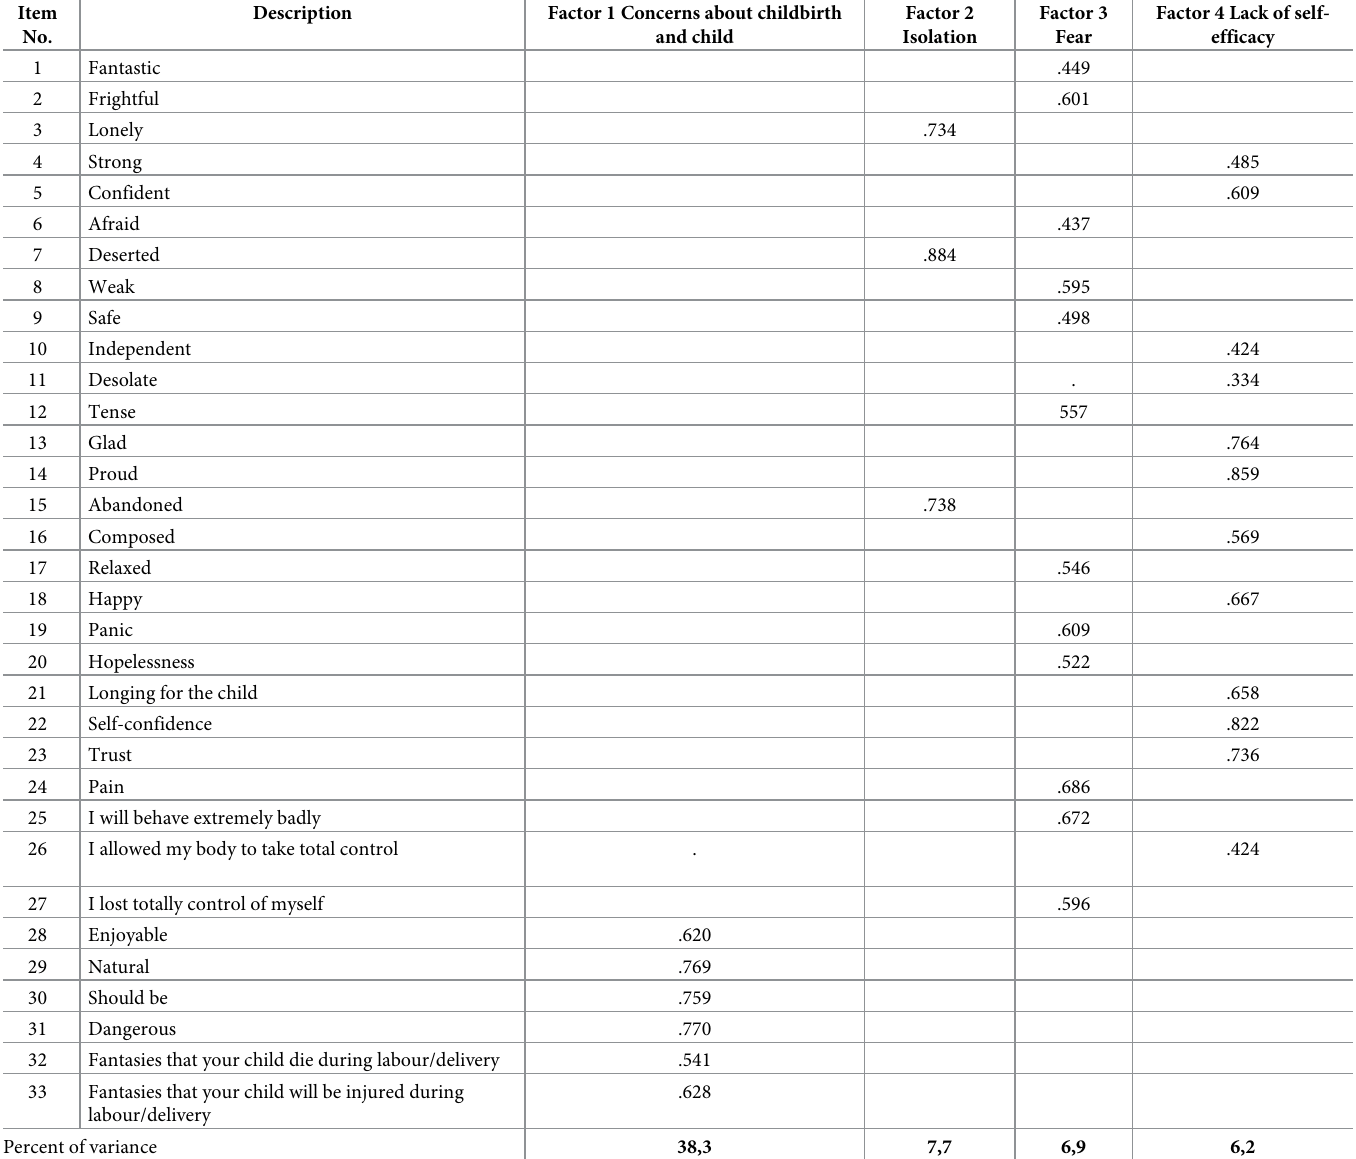
Table 4. Loading matrix related to the exploratory factor analysis solution. Item No.